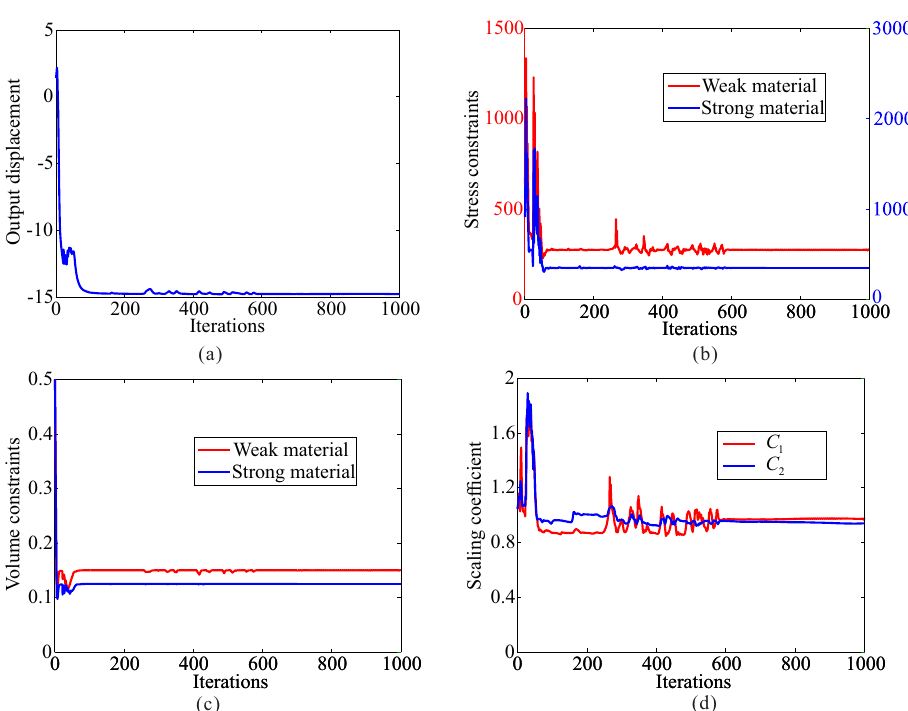
Figure 4. The convergence history for topological design of multi-material compliant inverter with global stress constraints ( σ ∗ = 275 MPa, σ ∗ = 350 MPa). ( a ) Output displacement; ( b ) stress constraints; ( c ) volume constraints; ( d ) scaling coefficient.